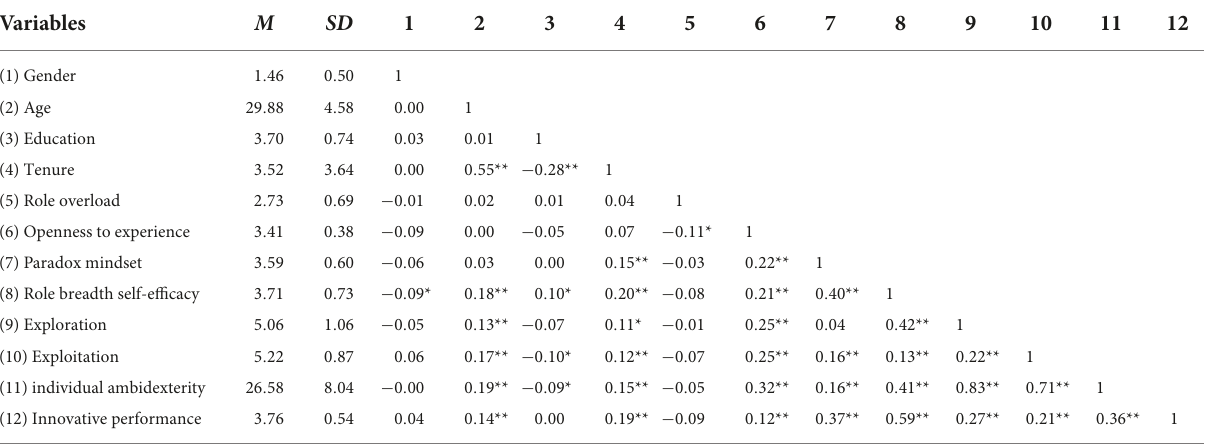
TABLE 3 Descriptive statistics and correlations among the study